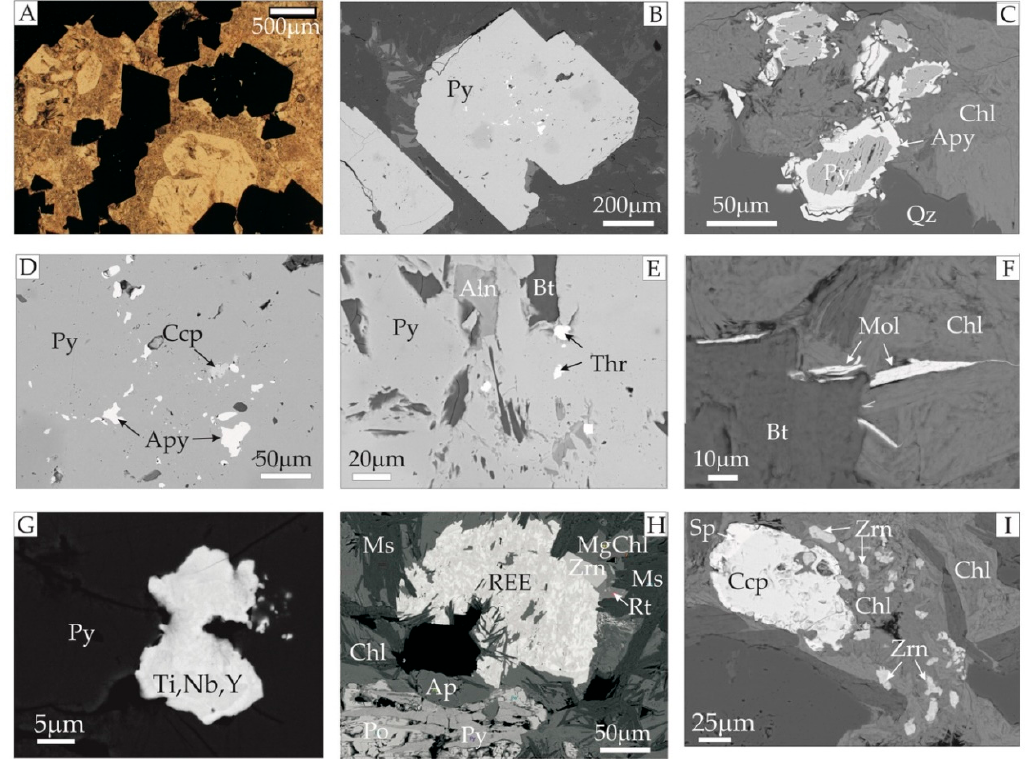
Figure 9. Ore mineralization from rhyolite porphyry Sample M2 from the central ore field in the abandoned Miedzianka Cu(-U) deposit. ( A ) Rhyolite porphyry from the Miedzianka deposit with disseminated pyrite (black) and quartz phenocrysts in a quartz-feldspar matrix. 1N, transmitted light; ( B ) automorphic pyrite (Py) crystals with fine inclusions of sulfides (white); ( C ) arsenopyrite (Apy) replacing medium-size pyrite; ( D ) numerous fine inclusions of arsenopyrite (Apy) and chalcopyrite (Ccp); ( E ) fine inclusions of thorite (Thr), allanite (Aln) and biotite (Bt) hosted by pyrite (Py); ( F ) fine blades of molybdenite between biotite (Bt) and chlorite (Chl) crystals; ( G ) very fine inclusion of an unidentified Ti, Nb, Y and REE-bearing mineral hosted by pyrite (Py); ( H ) aggregate of REE-bearing unidentified minerals associated with chlorite and other minerals within coarse-grained pegmatite intergrowths hosted by rhyolite porphyry. Abbreviations: REE—unidentified REE-bearing minerals with contents of Y, Ti, Nb, W, Th and U oxides; Ap—apatite; Chl and MgChl—Mg enriched chlorite; Ms—muscovite; Zrn—zircon; Rt—rutile. ( I ) chalcopyrite (Ccp) with sphalerite (Sp) associated with chlorite (Chl) and numerous fine-grained zircons (Zrn).